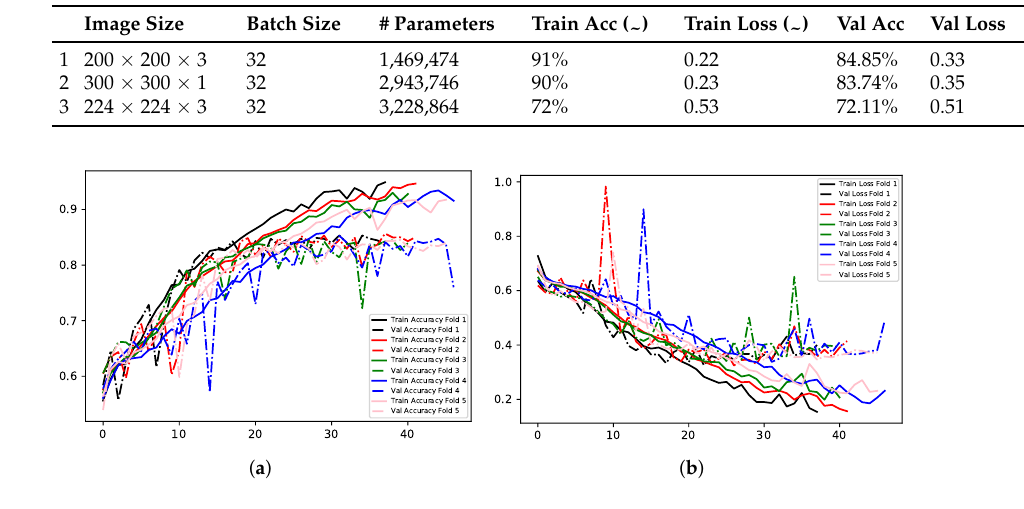
Figure 15. Model C Experiment 1 Results. ( a ) Accuracy. ( b ) Loss.